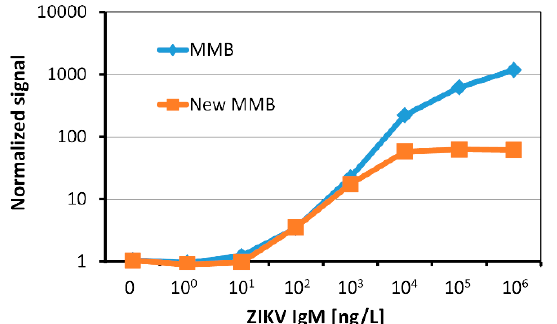
Figure 10. Dose responses of recombinant human IgM anti-Zika NS1 using a small footprint MMB system (“New MMB”) and a standard MMB system (“MMB”).